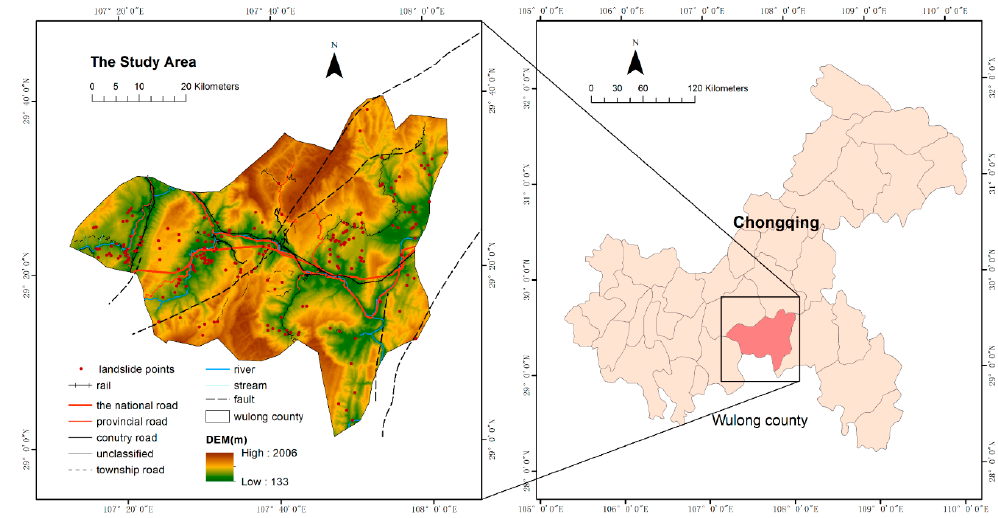
Figure 1. Position and landslide inventory map of the study area.